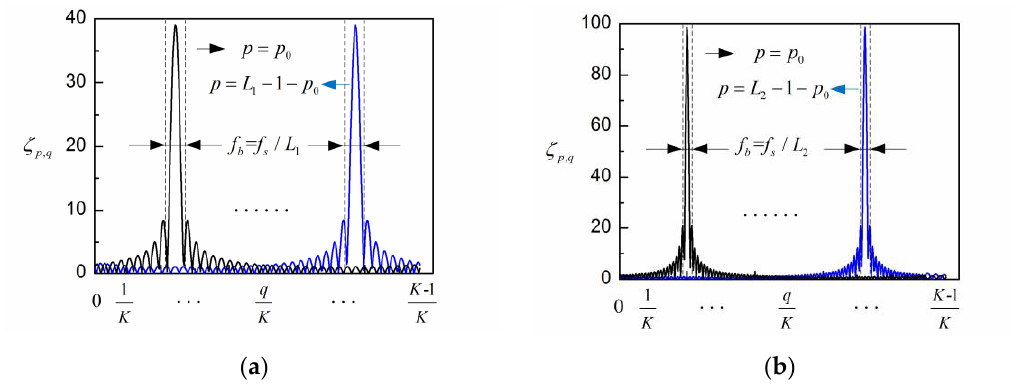
Figure 1. The coefficients ζ for different parameters of L and p: ( a ) L 1 = 20; ( b ) L 2 = 50.